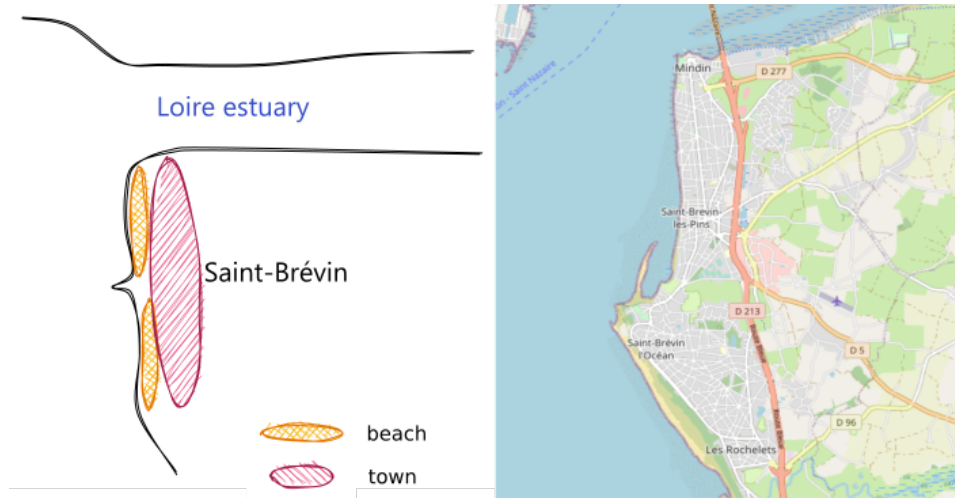
Figure 4. Illustration of the spatial distortion effect with a mental representation of Saint-Brévin, France on the left and the corresponding map extract on the right (©OpenStreetMap contributors).